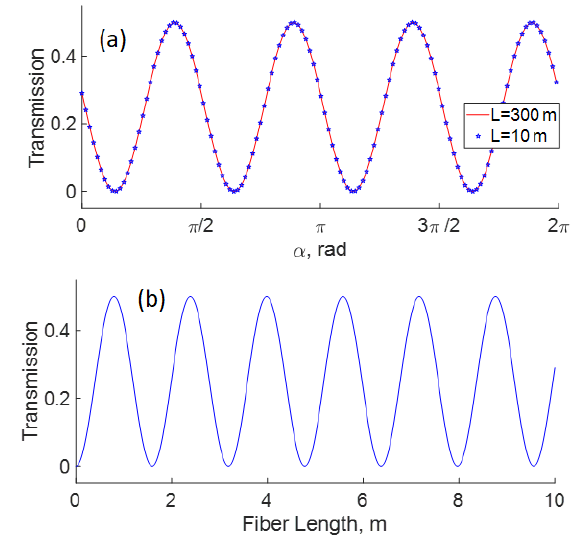
Figure 2. Dependence of Sagnac transmission on ( a ) angle α of QWR in the Sagnac loop, ( b ) loop length (for α = 0). The traces are calculated by using Equation (1), with q = 14 π , h = 0.13, and n =